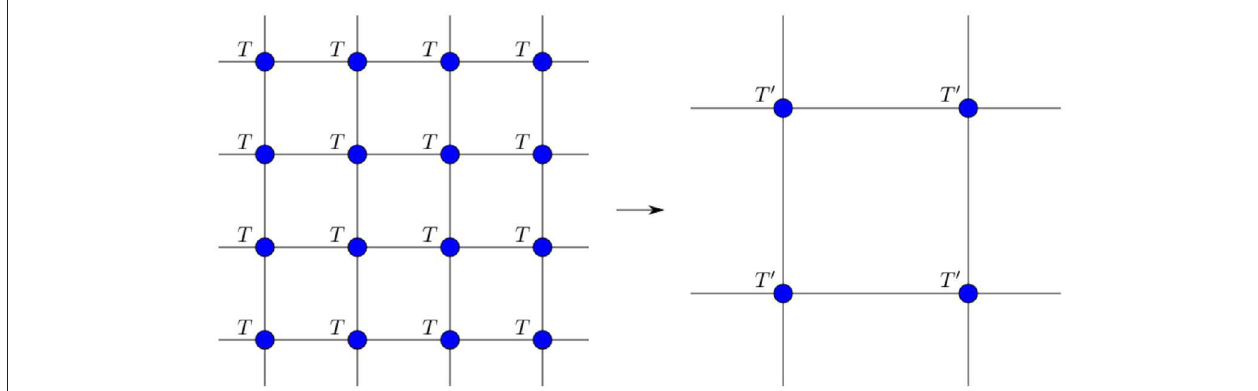
FIGURE 7 | The basic idea of tensor network renormalization: write the partition function as a contraction of a tensor network of tensors T and then locally manipulate the tensors, such that the same partition is approximated by a coarser network of effective tensors T ′ . This defines a flow in “tensor